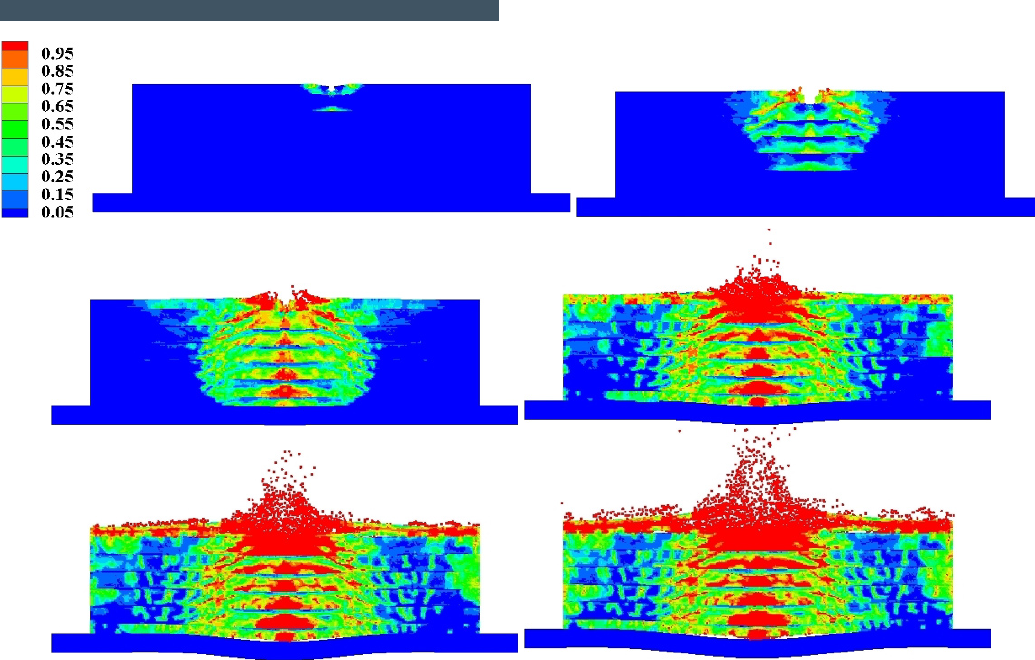
Figure 4. The time-evolution of the damage map for the through-thickness cross-section (displacements are amplified in this figure by a factor of 2 for better visualization). From left to right, snapshots taken at 12, 27, 43, 79, 110, and 161 µ s from the contact between the projectile and the glass laminate. The legend for the damage map used here is used in all remaining figures. See movie